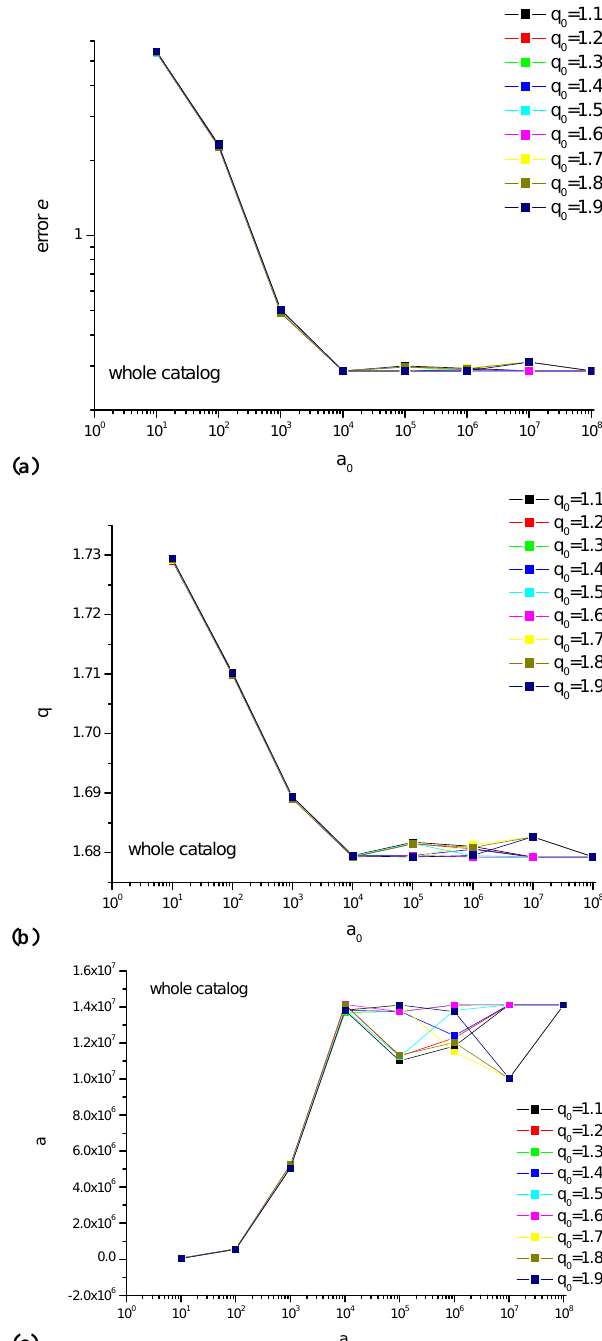
Fig. 3. The error e (a) and the parameters q (b) and a (c) versus initial value a 0 , calculated for the whole seismicity. The different colored curves are obtained with different values of q 0 . The value of the error e is stable for a 0 ≥ 10 4 ; in this range the obtained values of q and a are also quite stable, with q around 1.68 and a of the order of 10 7 . The minimum error is ∼ 0.2868 and was obtained for q 0 =1.4 and a 0 =10 7 ; then, these initial values were used to find the best fitting parameters q =1.679 and a =1.4 × 10 7 for the fitting curve, shown in Fig.